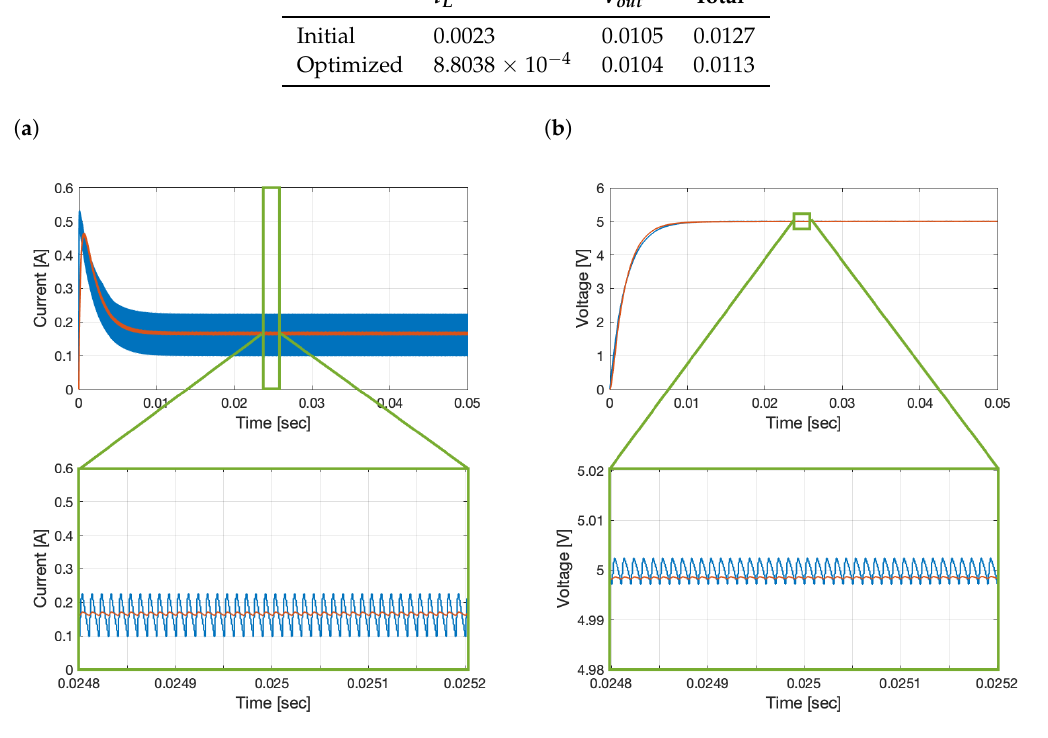
Figure 17. ( a ) Inductor current and ( b ) output voltage response with a 30 [ Ω ]